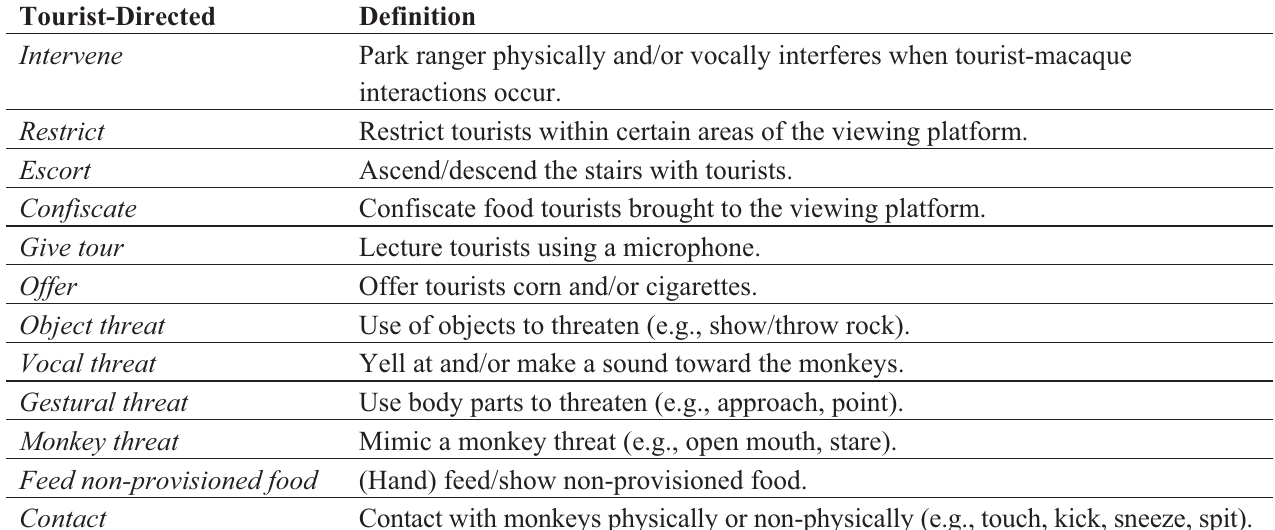
Table 1. Definitions of park ranger